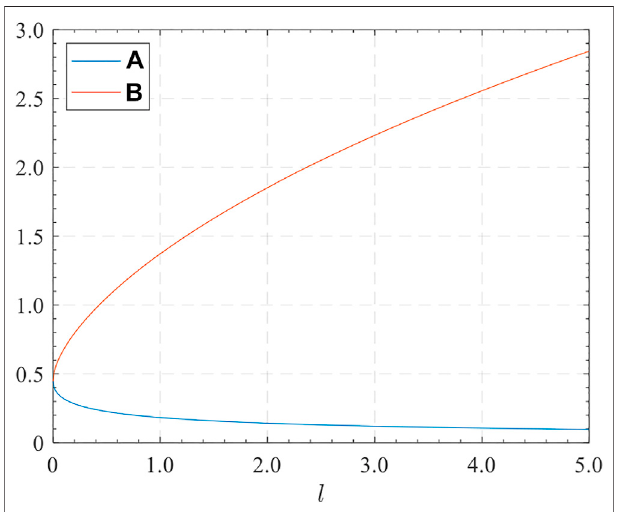
FIGURE 5 | Stress coef fi cients (A and B) versus l .